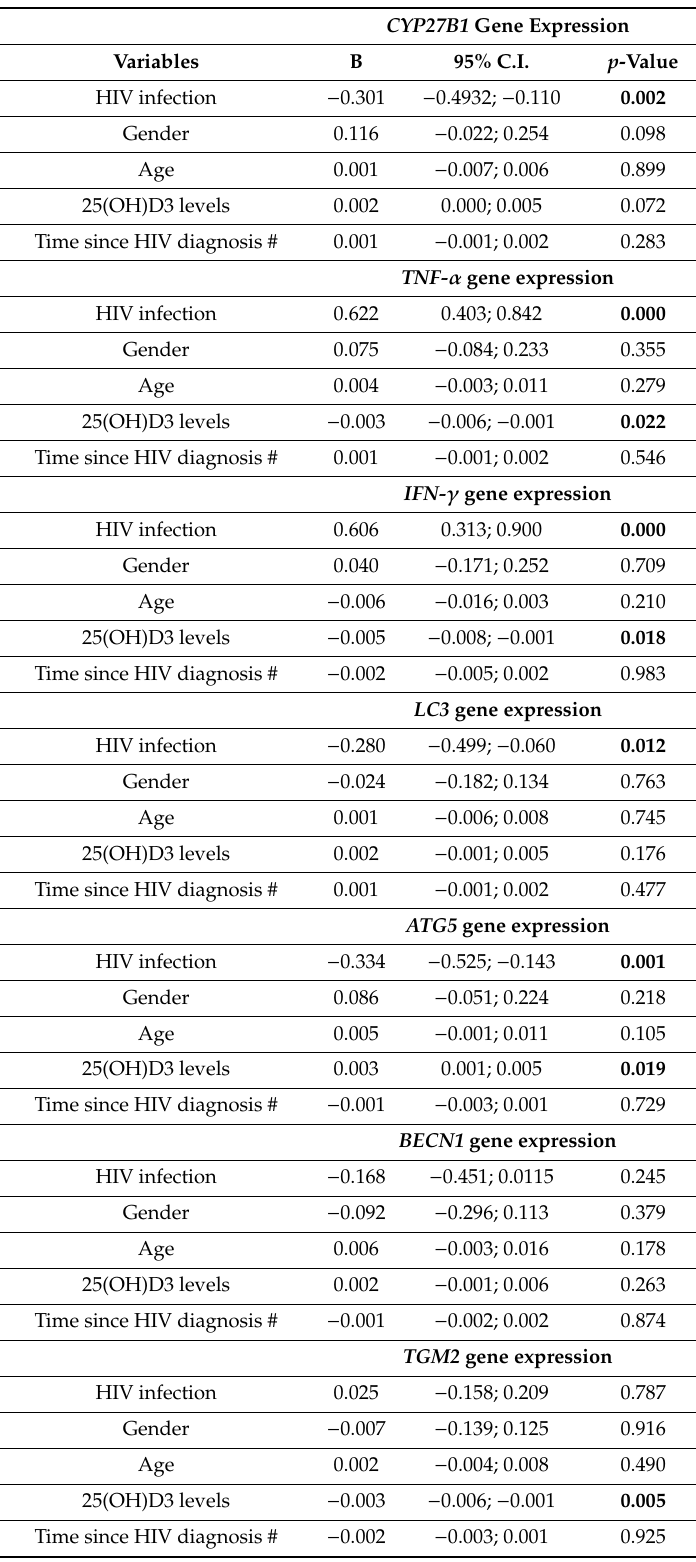
Table 2. Generalized linear model (GLM) for gene expression, accounting for the influence of HIV infection, 25(OH)D 3 levels, gender, age, and time since HIV